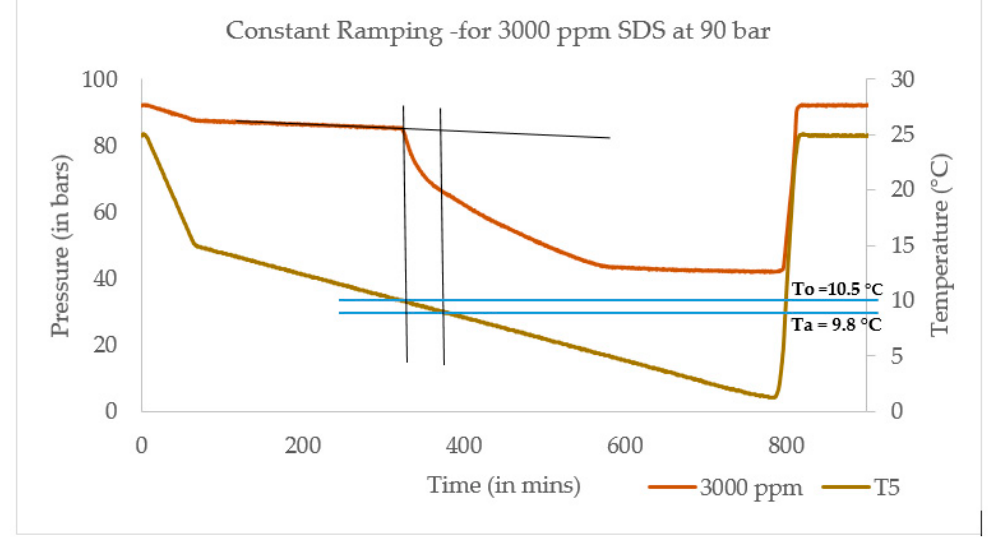
Figure 2. Graphical representation demonstrating typical method to determine T 0 and T a with P–T graph generated from constant cooling experiment.